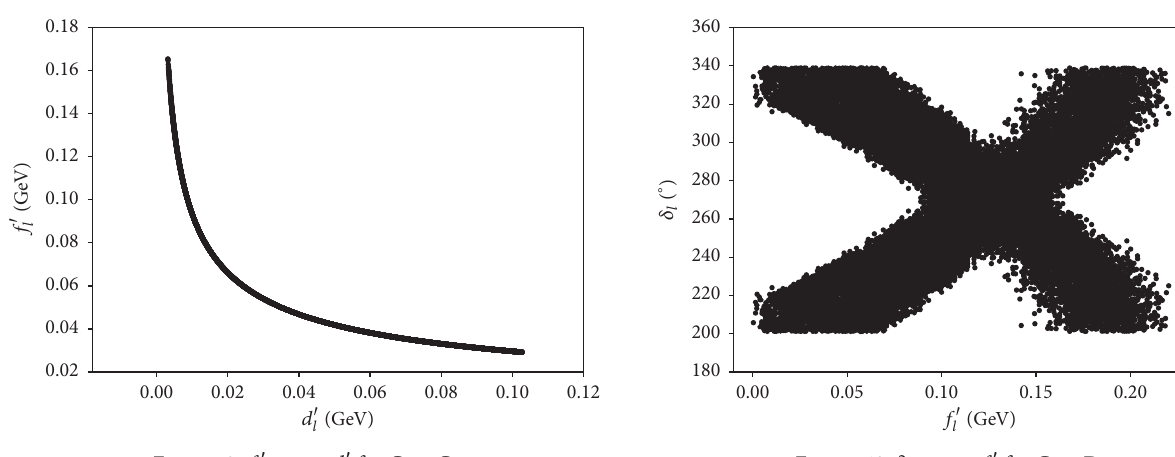
Figure 8: 𝑓 󸀠 𝑙 versus 𝑑 󸀠 𝑙 for Case C.